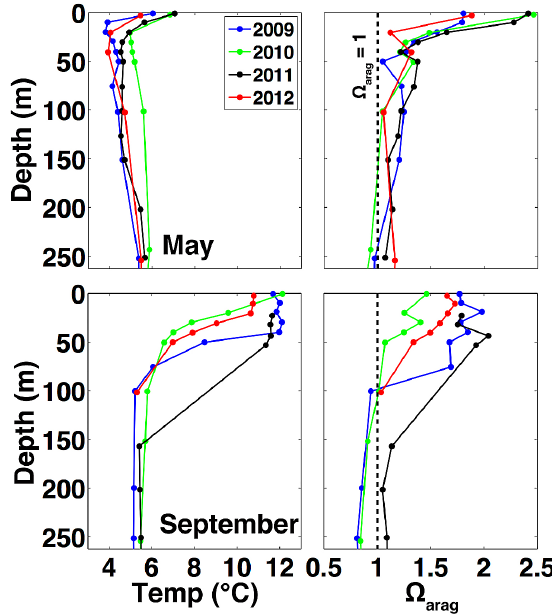
Fig. 10. Temperature ( ◦ C; left) and (cid:127) arag (right) for K.I.P. station PWS2 (Fig. 1) for spring (top) and autumn (bottom) from 2009 through 2012. The dashed vertical lines in the right panels denote the (cid:127) arag = 1 level below which aragonite will